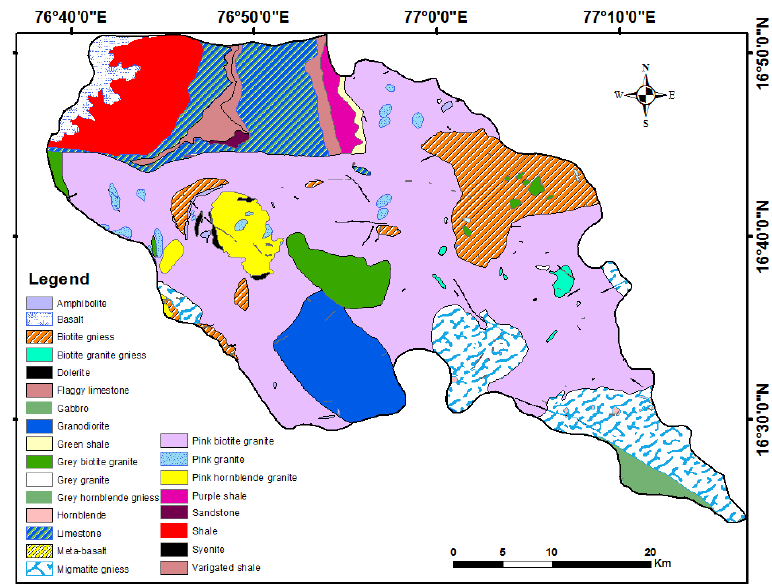
Figure 2. Lithology of the study area.